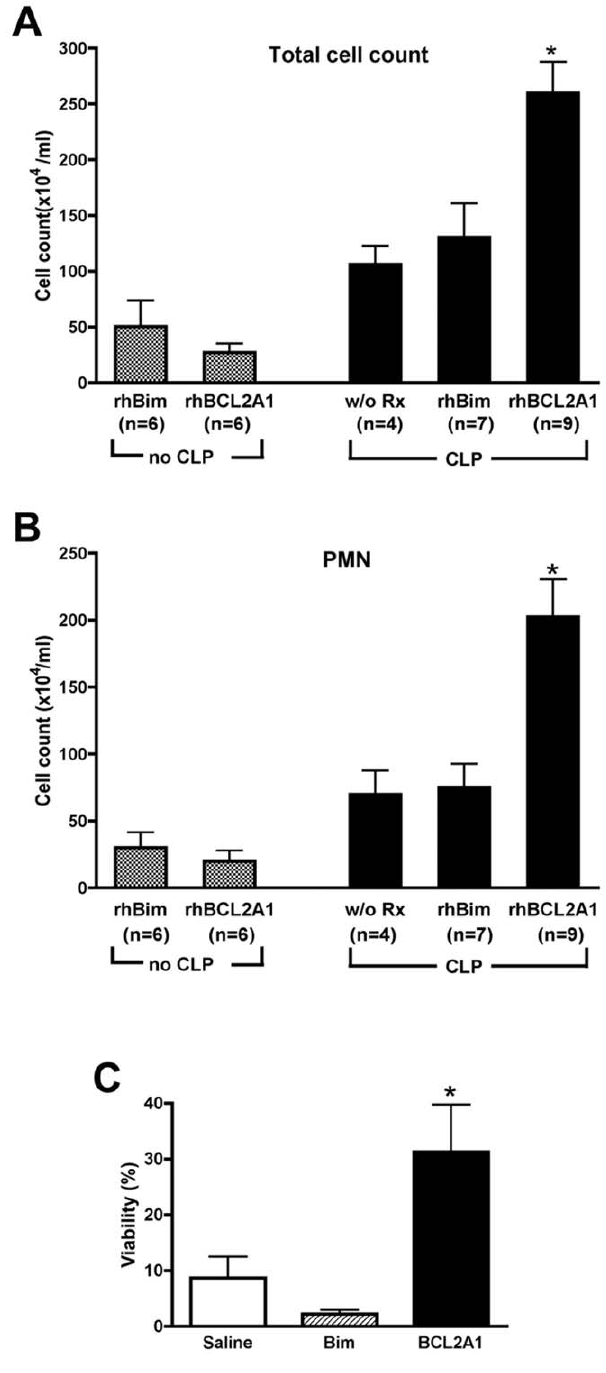
Figure 5. Treatment with rhBCL2A1 increases neutrophils in peritoneum following CLP. Mice were treated once by i.p. injection with 1 m g of rhBCL2A1 or rhBim at 18 hours prior to CLP. Peritoneal lavage fluid was collected at 24 hours following CLP. Panels A and B show the total number of leukocytes and neutrophils (PMNs) in lavage fluid. Mice treated with rhBCL2A1 showed an increase in peritoneal PMNs following CLP as compared to mice that did not receive CLP or mice that were treated with rhBim. Panel C shows the viability of